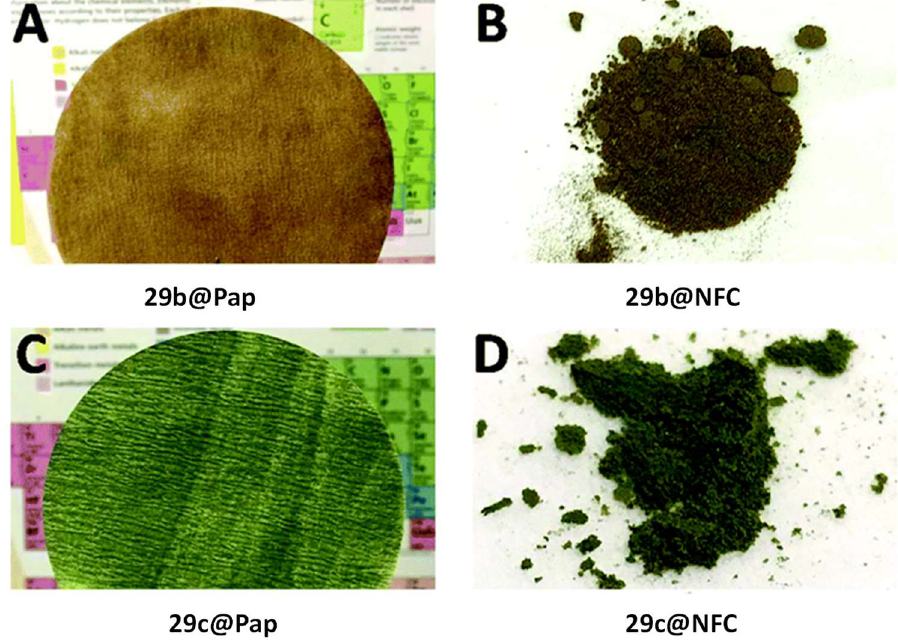
Figure 22. PS–cellulose conjugate materials ( A ) 29b@Pap ; ( B ) 29b@NFC ; ( C ) 29c@Pap ; ( D ) 29c@NFC . Reprinted with permission from Ref. [125] . © The Royal Society of Chemistry 2019.